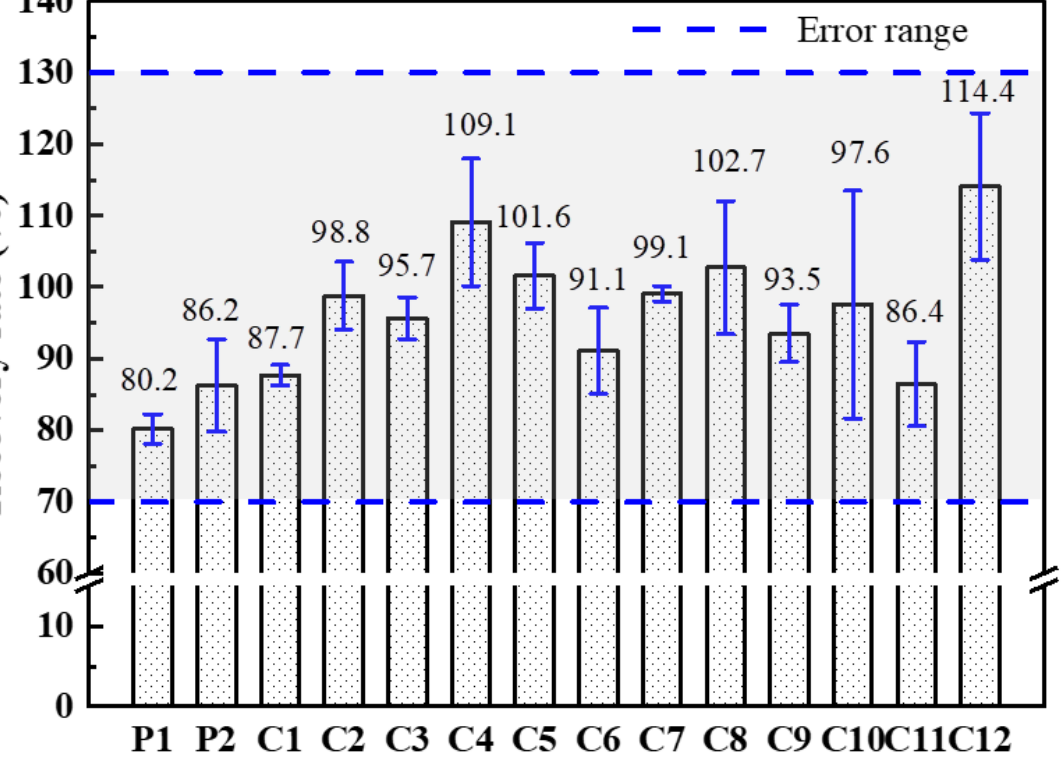
Figure 2. Hg recovery rate in coal samples by the SCE